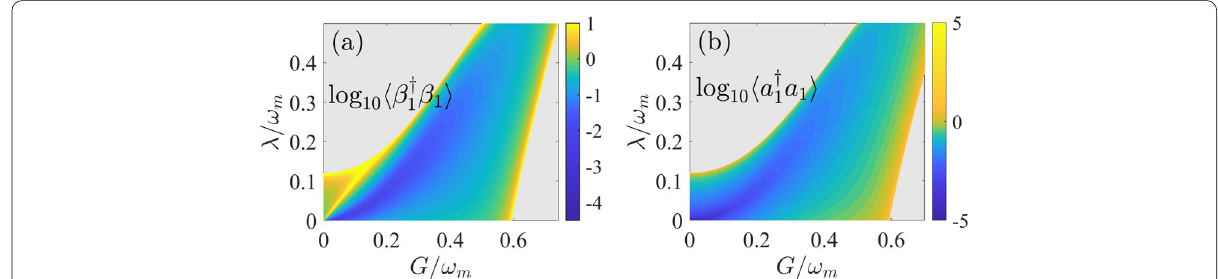
β † 1 β 1 and b the steady‑state population number of the photon mode (cid:31) (cid:30) 0.5 ω m . The other parameters are the same as Fig. 2 =